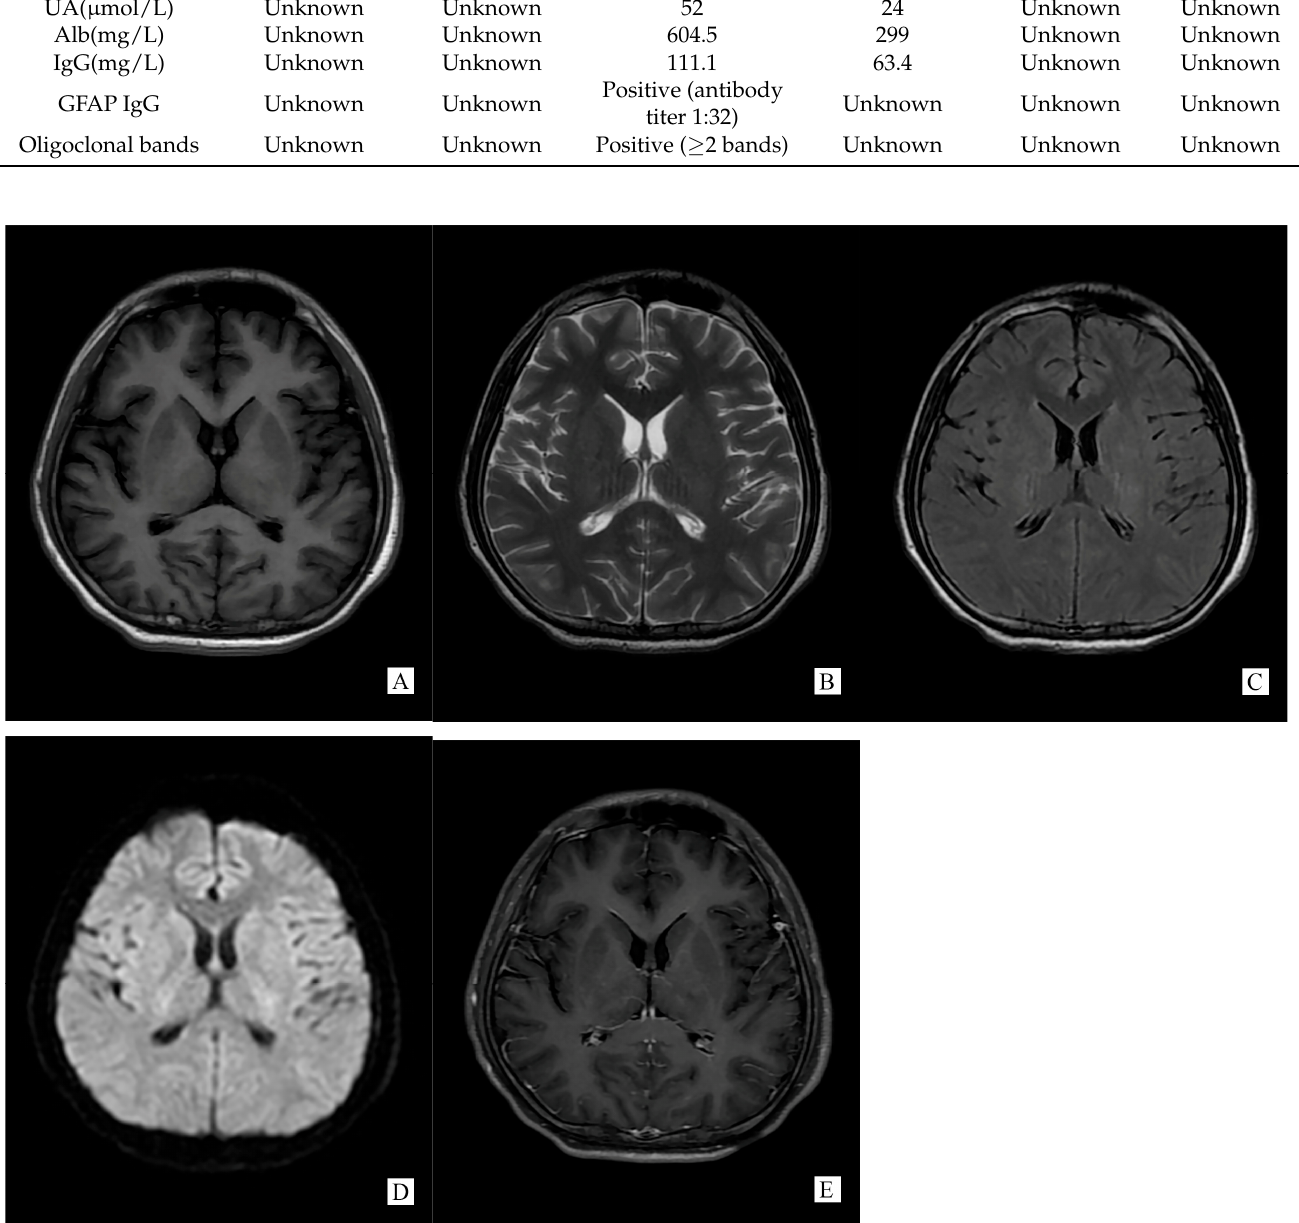
Figure 2. (Performed on 13 November 2021) SCC lesion totally disappeared on brain MRI (( A ). T1WI, ( B ). T2WI, ( C ). T2 fl air, ( D ). DWI, ( E ). Post-gadolinium T1-weighted). Based on the combination of clinical features, CSF test, and cerebral MRI changes, we fi nally diagnosed the patient with autoimmune GFAP astrocytopathy accompanied with RESLES. On 12 November 2021, the second day of antiviral treatment, his body temperature returned to normal without headache. However, di ffi culty and frequency of urination still persisted. We then gave a high-dose intravenous steroid starting on 15 November 2021 at 1 g/day for 4 days followed by 0.5 g/day for 1 day and 0.25 g/day for 3 days. Rechecked spinal tap on 17 November 2021 revealed CSF WBC counts 240 × 10 6 /L, normal CSF protein, glucose, and chloride (Pro 0.45 g/L, Glu 3.61 mmol/L, Cl - 128.00 mmol/L). On 22 November 2021, the patient was discharged from hospital with oral cor- ticosteroids and go home to outpatient follow-up. During follow-up, his neurological symptoms were completely recovered within 3 months. Steroid therapy was progres- sively tapered over 6 months until complete withdrawal. A lumbar puncture was per- formed on 11 May 2022 before steroid withdrawal showed CSF WBC counts for 16 × 10 6 /L, normal CSF protein, glucose, and chloride levels. All the CSF results during hos- pitalization and outpatient visits are listed in Table 1.